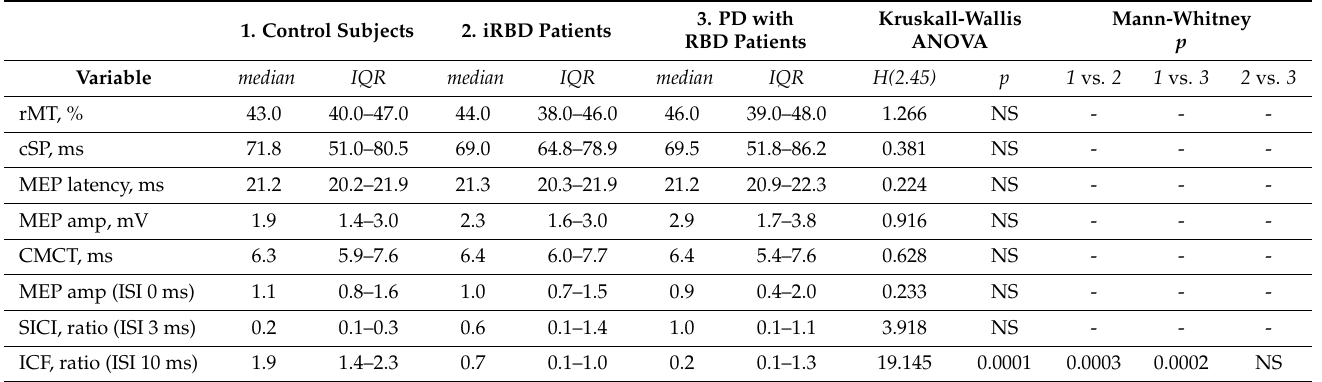
Table 2. Single and paired-pulse TMS comparison between patient groups and healthy